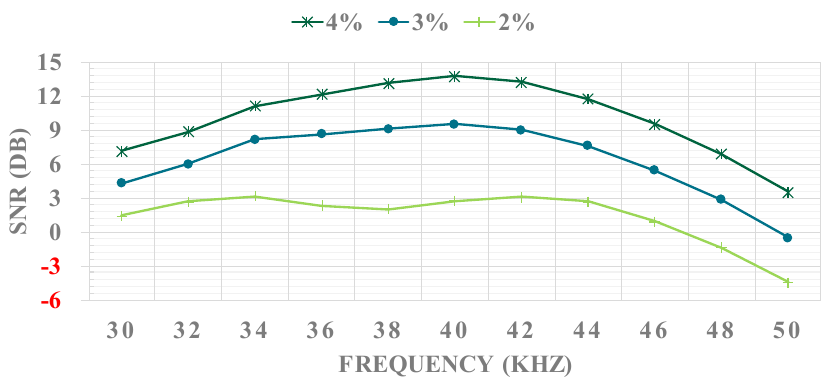
Figure 17. Signal-to-noise ratio (SNR) of the defect signal in each experimental test case. Table 3. Achieved SNR from defect signal in each test case (in dB).